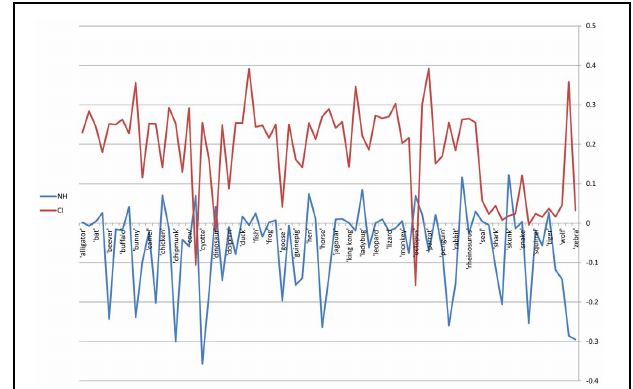
FIGURE 3 | Word impact score for both word-matched correlation networks. The NH network is denoted in blue, and the CI network is denoted in red. X -axis—75 word-matched nodes. Y -axis—centrality